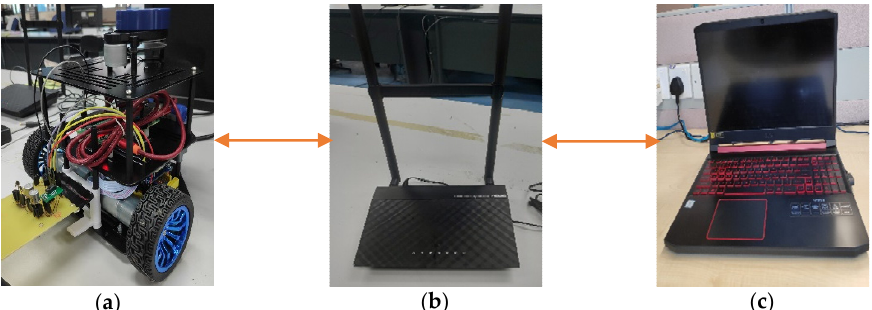
Figure 2. Full-duplex communication from the ( a ) base station through wireless communications of ( b ) Router to ( c )